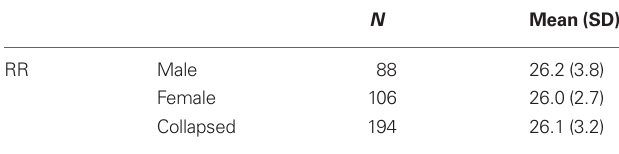
Table 1 | Descriptive statistics of the RR scale divided by gender (Study 1).